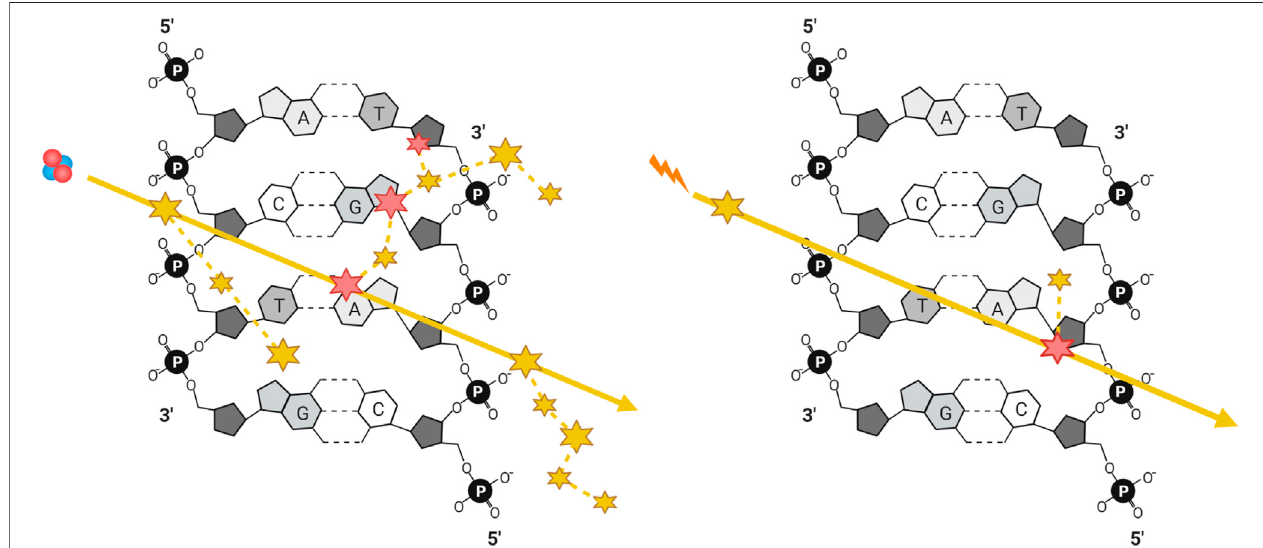
FIGURE2| Simpli fi edillustrationofenergydepositionofequivalentdosesofahigh-LETparticleandalow-LETphotongeneratedsecondary electron,withionizing (large) andexcitation(small)eventsalongtheirtrajectories, represented bysolidyellowarrows.DNAdamagecanbegeneratedeitherdirectlythroughionization(large) or indirectly through generation of radicals after the ionization or excitation of water (small), where dashed yellow lines represent the trajectories of secondary electronsand delta rays.